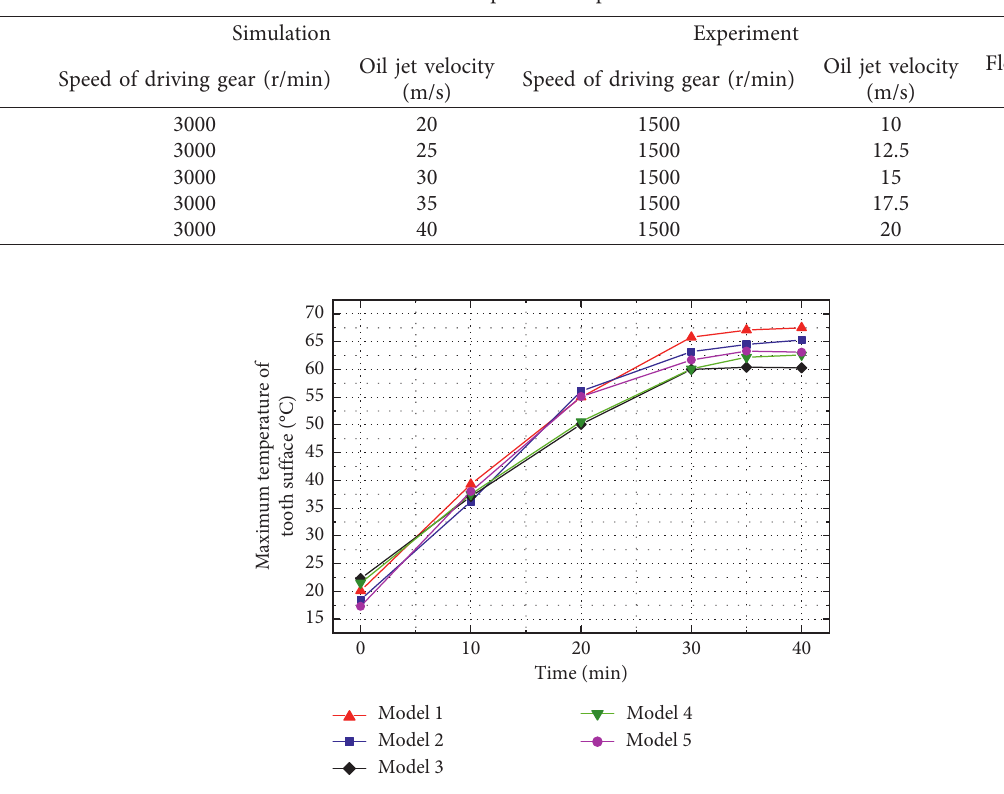
Figure 20: The variation trend of tooth surface temperature with time under different models’